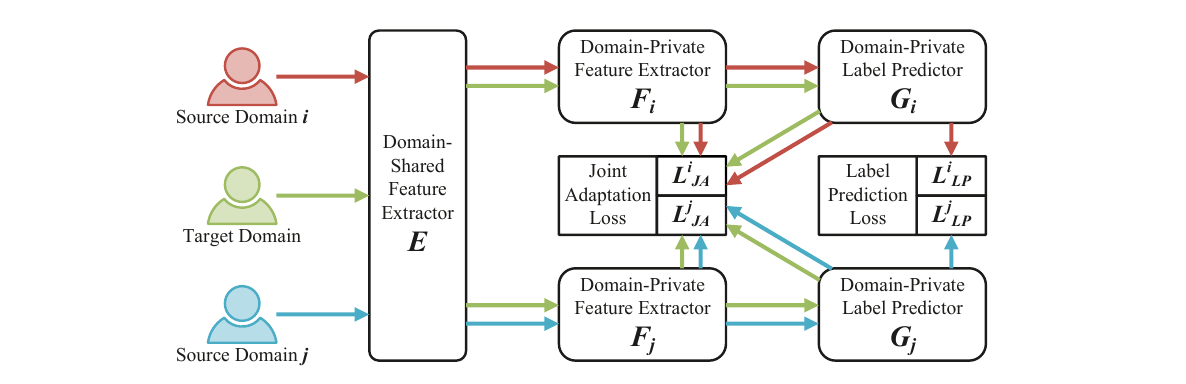
FIGURE1 The proposed multi-source joint domain adaptation (MSJDA) framework. For brevity, here, only the i-th and j-th (i (cid:54)= j and i , j ∈ { 1 ,..., K } ) of the K source domains are selected to present our network